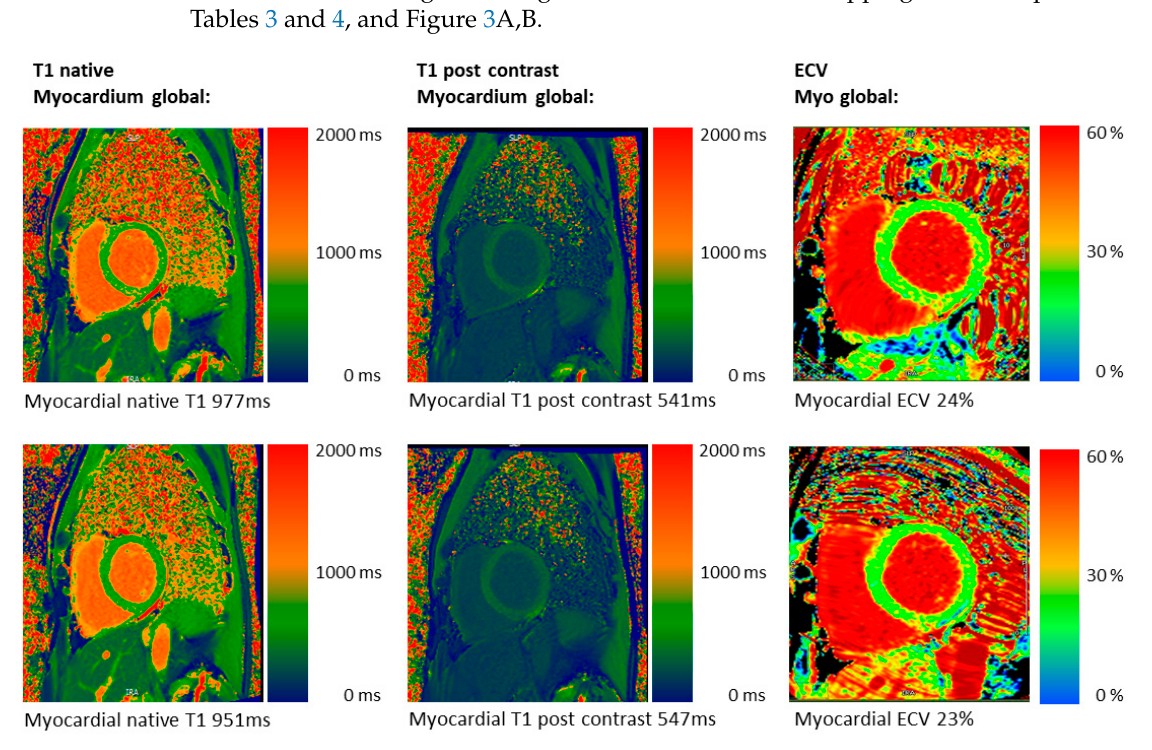
Figure 2. Clinical T1 mapping images in vivo. CMR images of a 48-year-old male patient with an athlete’s heart and screening for DCM with both MOLLI acquisition schemes: 5(3)3 (top row) and 4(1)3(1)2 (bottom row). The native T1 images show lower native T1 values for 4(1)3(1)2 (blue colors) compared to 5(3)3. Post-contrast and ECV are similar for both acquisition schemes. Table 3. T1 mapping in all patients.